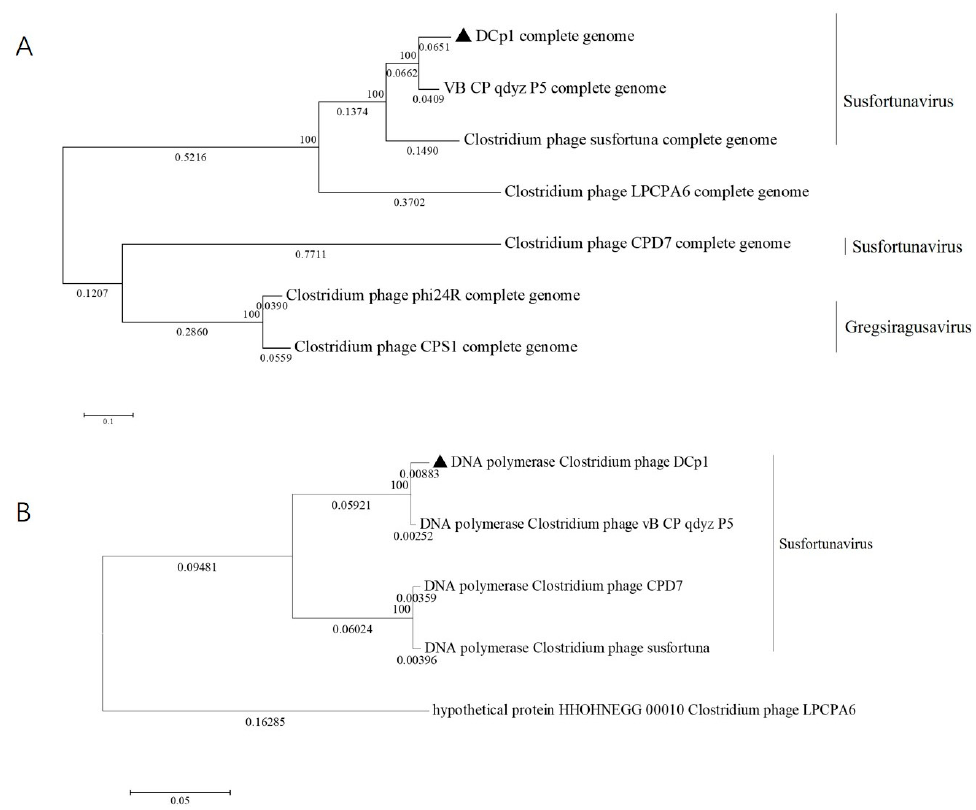
Figure 6. Phylogenetic trees showing the relationship between phage DCP1 and other phages in the NCBI database. ( A ) Phylogenetic tree based on the whole genome. ( B ) Phylogenetic tree based on DNA polymerases.